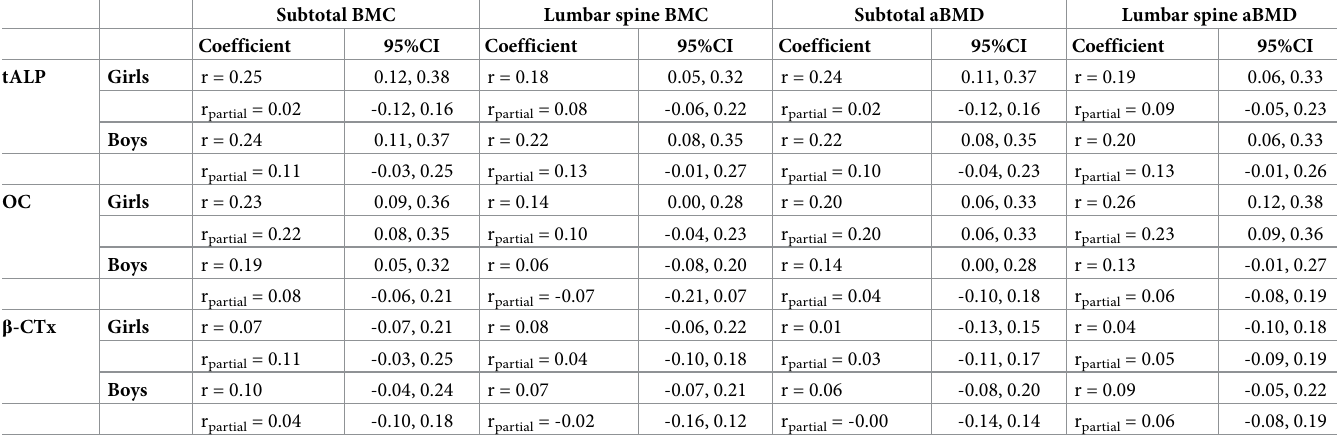
Table 3. Pearson correlation and partial correlation coefficients between bone metabolism markers and bone mineral content and density, in girls and boys (n = 395). Subtotal